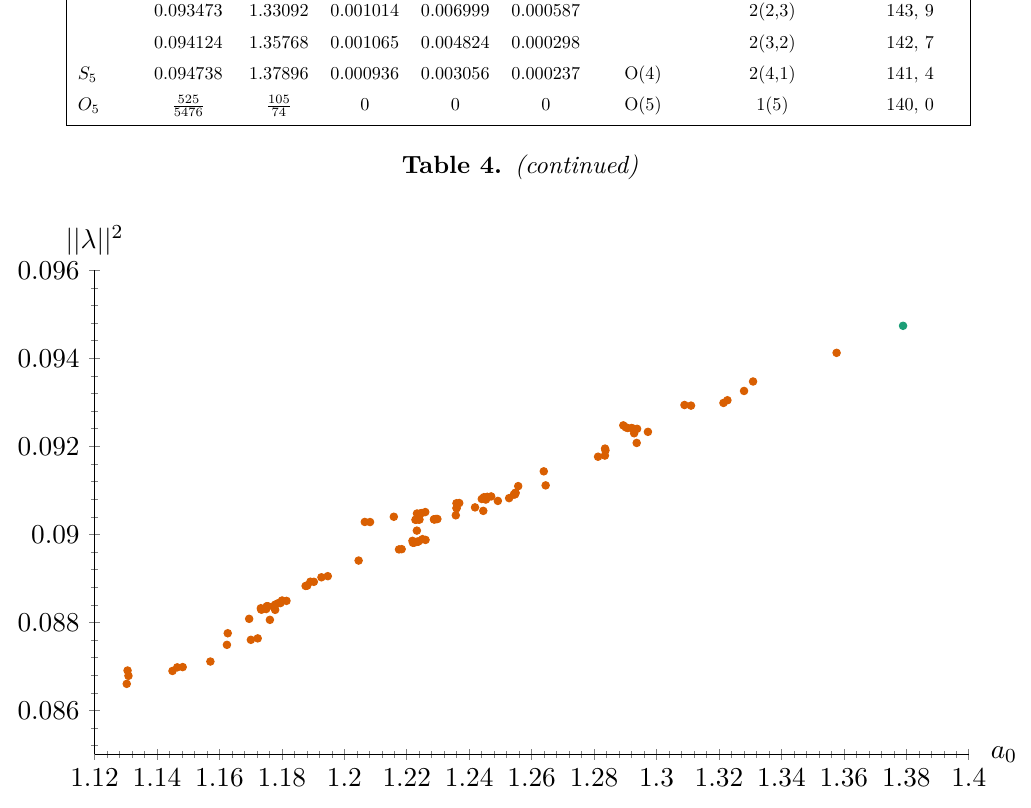
Figure 6. Fully-interacting fixed points for N = 5 in d = 3 − ε .